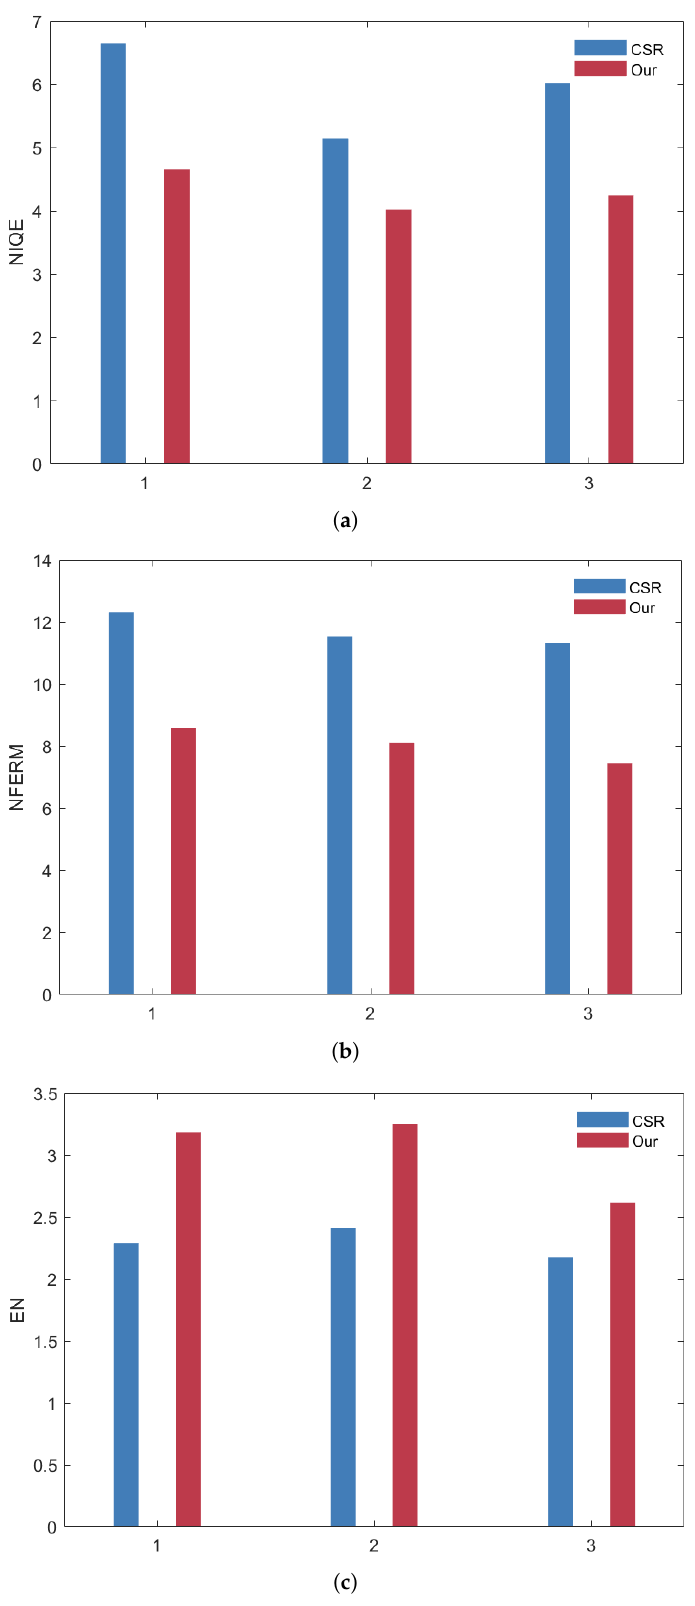
Figure 17. Quantitative comparison with CSR algorithm. The lower the NIQE and NFERM, the better the performance. The higher the EN, the better the performance. ( a ) NIQE results. ( b ) NFERM results. ( c ) EN